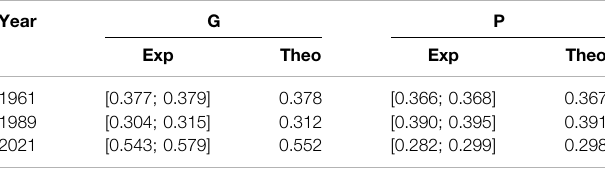
results. The Lorentz curves for the studied years are plotted on Figure 6 . The regions spanned by the experimentally observed Lorenz curves for different weight parameters are indicated with a lighter shedded region. The theoretical Lorenz curve computed with the fi tted probability density is indicated with a bold continuous line. As expected our theoretical model describes in an acceptable manner also the Lorenz curves. Some deviations are however observed for year 2021 in the limit of high wealths.